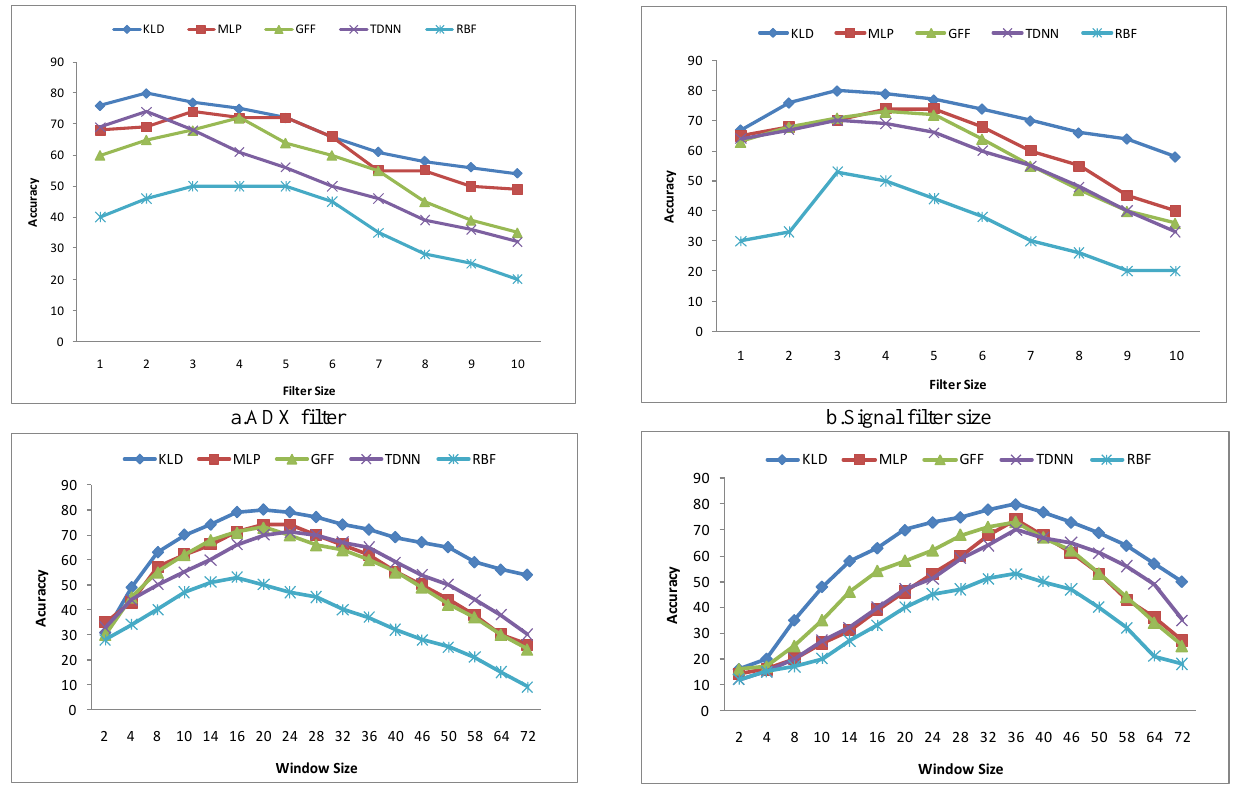
Fig. 5. Sensitivity analysis for data set parameters using HRHO